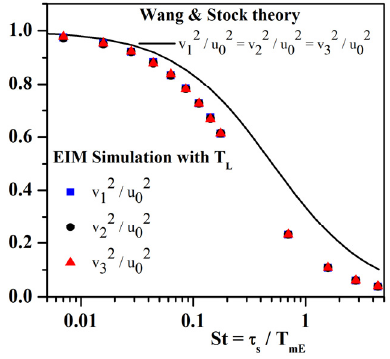
Figure 5. Normalized variance of particle velocity (g = 0).